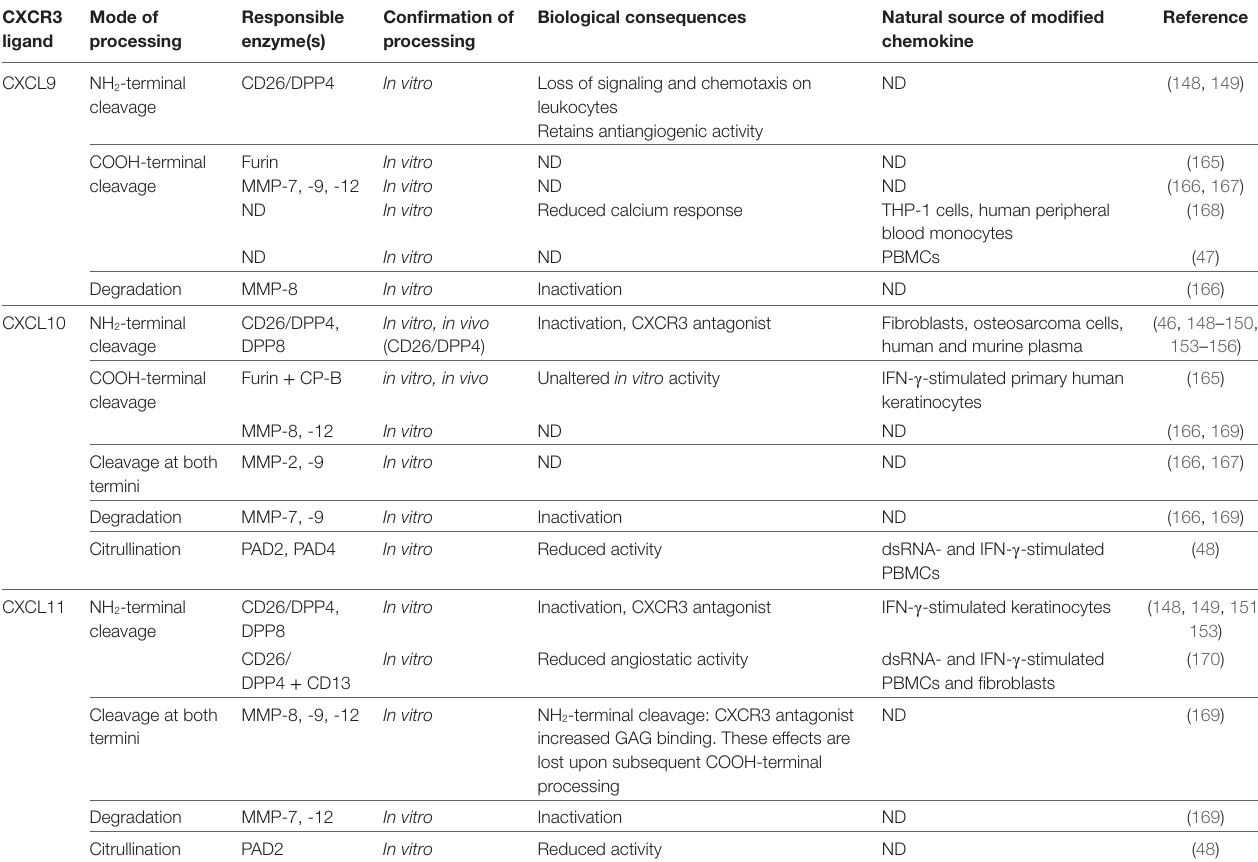
TABLe 2 | Posttranslational modifications of IFN-inducible CXCR3